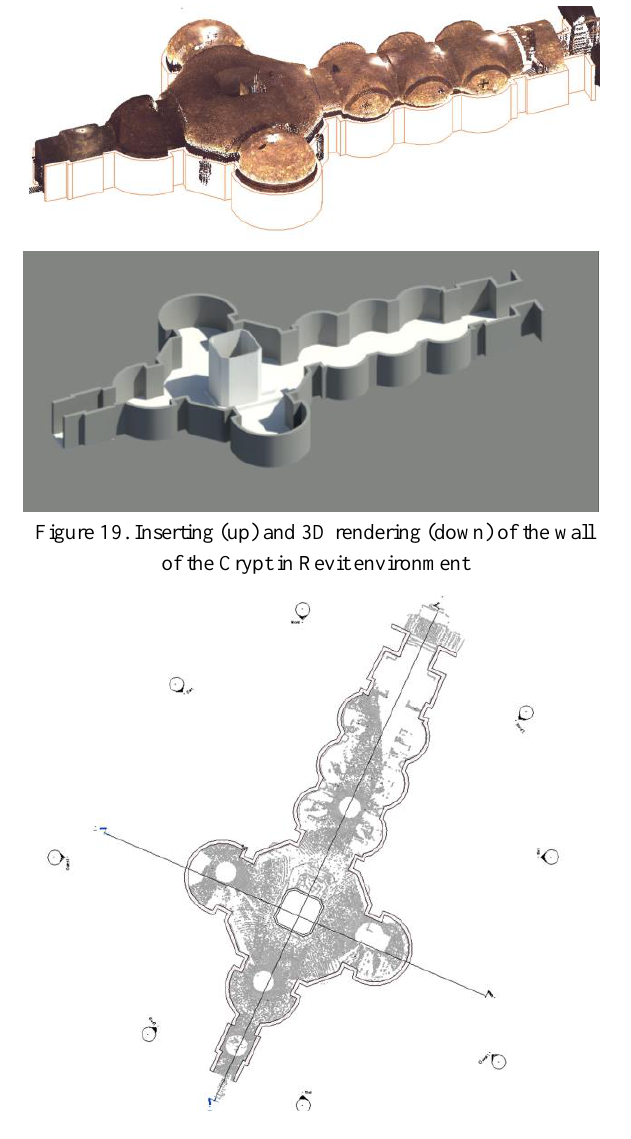
Figure 20. Lines of transverse and longitudinal sections of the Crypt in Revit environment